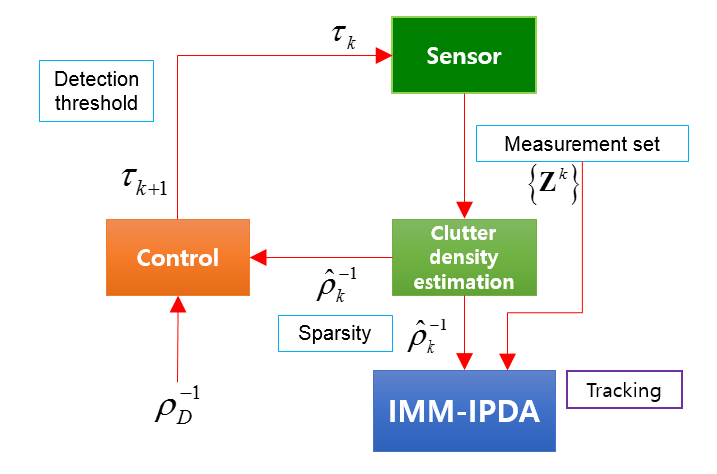
Figure 2. Structure of the target tracking system combined with the detection threshold adjustment. IMM-IPDA, interacting multiple model-integrated probabilistic data